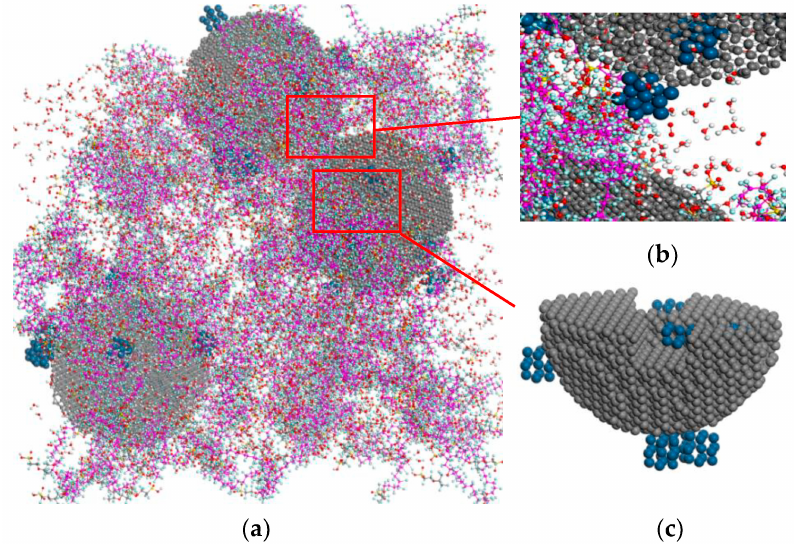
Figure 2. Molecular model of the multi-component catalyst layer between the PEM and GDL ( a ) molecular model of the catalyst later; ( b ) secondary pore; and ( c ) primary pore.